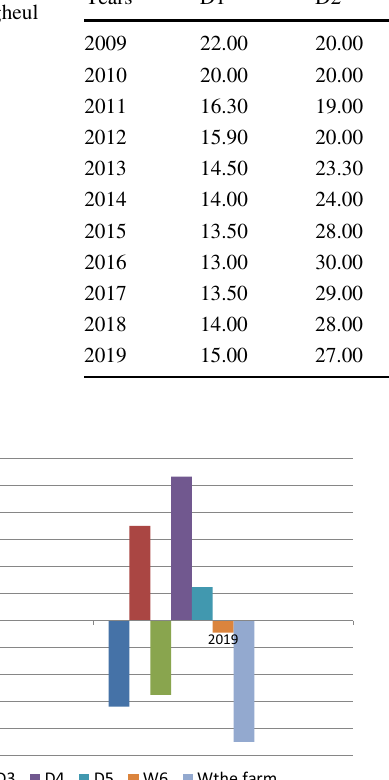
Table 10 Chloride (mg/l) values of water points in the Mougheul area (2009–2019)